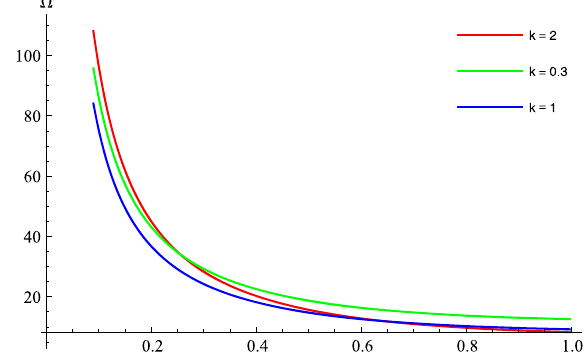
Fig. 1 Graphical representation of (cid:19) for case 1